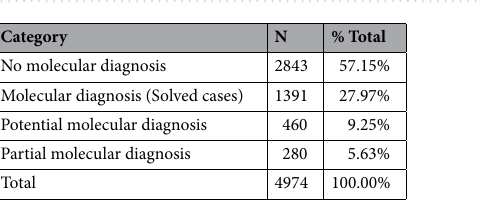
Table 1. Molecular, potential molecular, partial molecular and no molecular diagnosis cases in the analysed